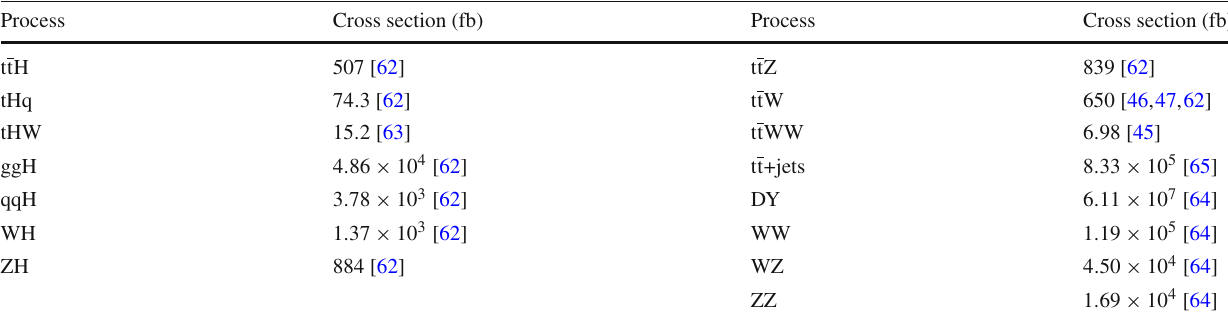
Table 1 Standard model cross sections for the ttH and tH signals as well as for the most relevant background processes. The cross sections are √ s = 13TeV. The quoted value for DY production includes a generator-level requirement of m Z / γ ∗ > 50GeV quoted for pp collisions at